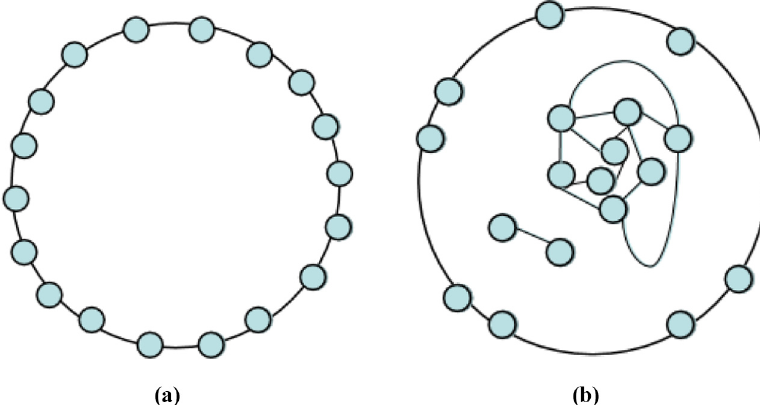
Figure 3. Example diagram of sparse network a,